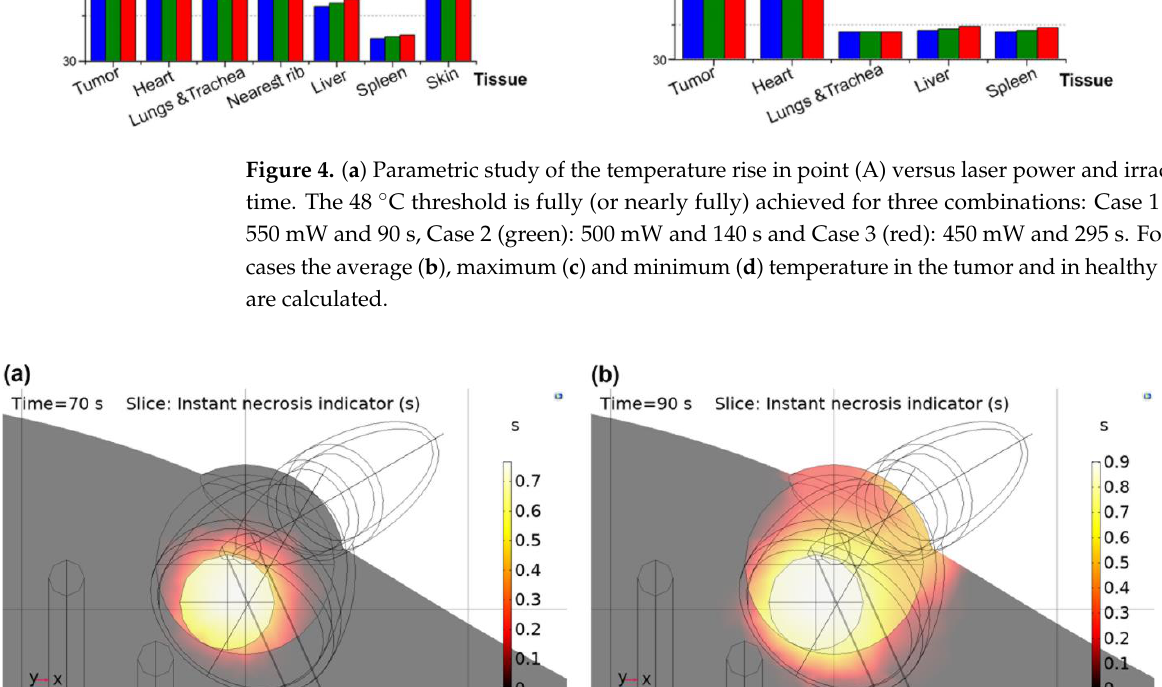
Figure 5. Spatial distribution of necrotic tissue at the x - z plane, after ( a ) 70 s and ( b ) 90 s of treatment. In the 70s scenario the skin is spared.